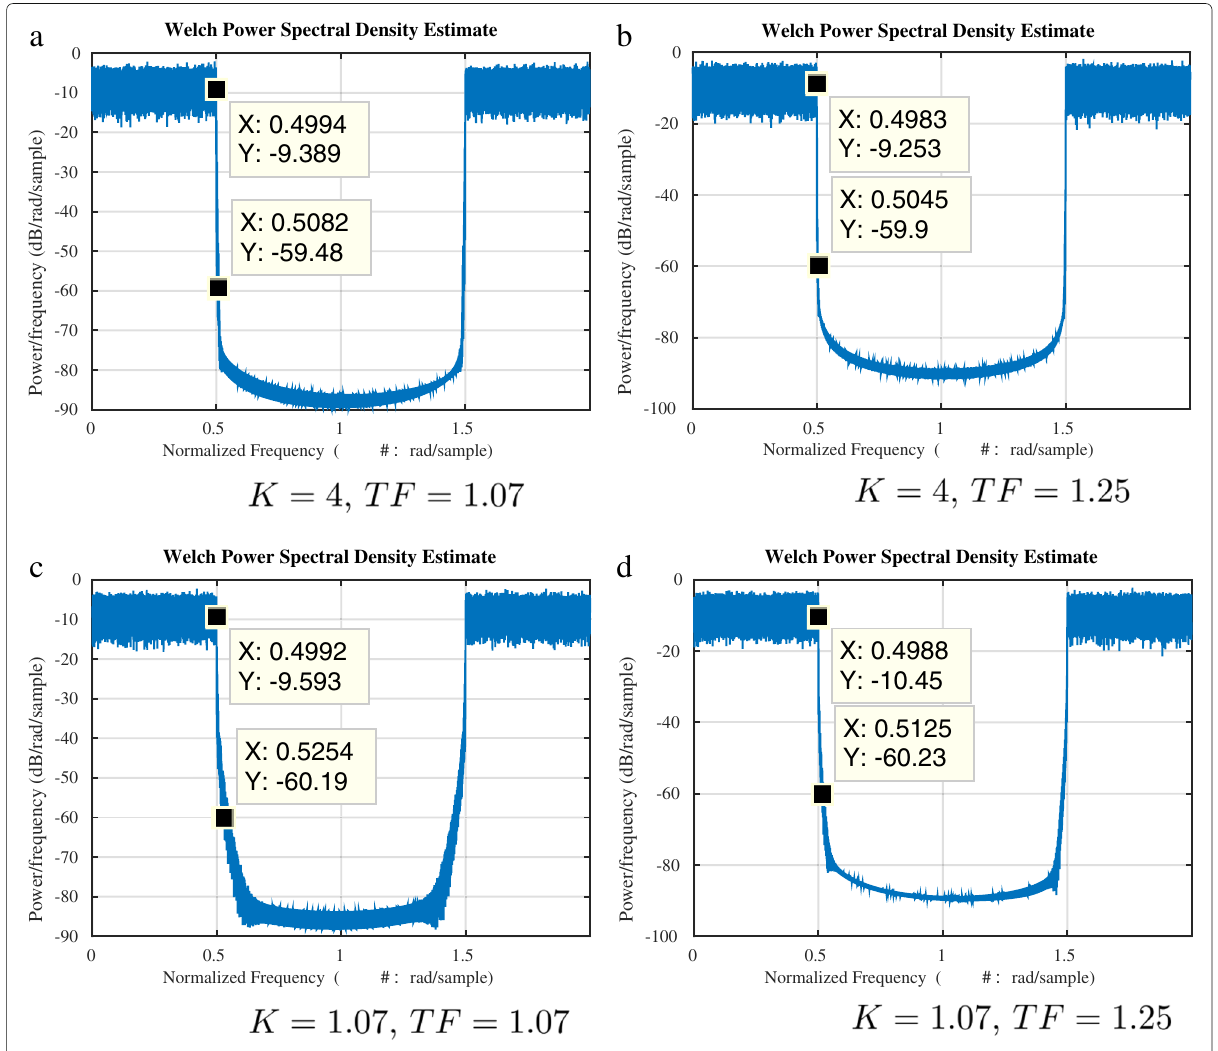
Fig. 15 a – d PSD analysis of pulse-shaped OFDM prototype